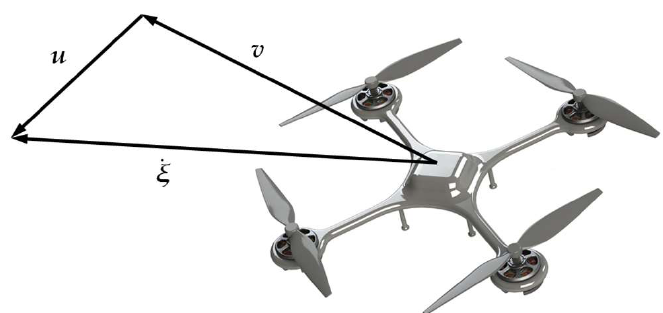
Figure 2. The relationship of the three velocities. ξ ̇ is the ground velocity, v is the airspeed vector and u is the wind velocity.